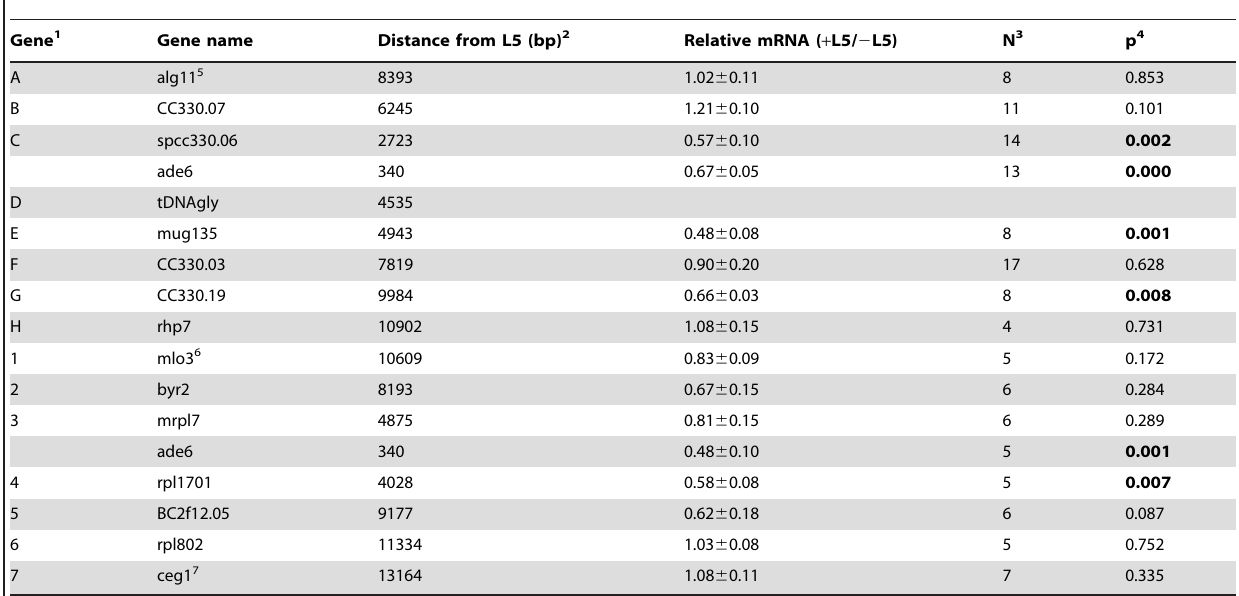
1 From Figure 1A and 1C. 2 Distance of the translation start site from the nearest edge of L5. 3 Number of independent RNA isolations included in analysis. 4 p-value resulting from comparison between ura4 :: ade6 + and ura4 ::L5- ade6 + strains. 5 Essential for viability [82]. 6 Mutation in mlo3 results in a growth defect [83]. 7 Essential for viability [84]. Relative gene expression in the ura4 and spbc2f12.03 loci. Steady-state mRNA for genes in the ura4 (A–H) and spbc2f12.03 (1–7) loci were assayed via quantitative RT– PCR and are reported relative to ura4 :: ade6 + control strains. The distance from the transcription start site to the nearest edge of L5 is indicated for each gene.